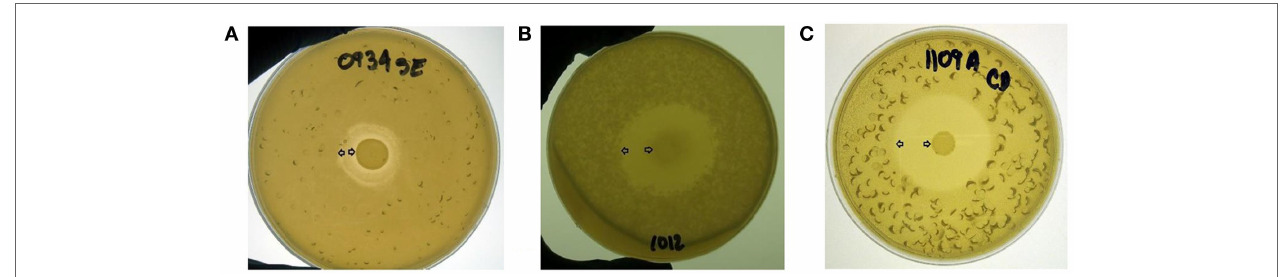
FigUre 2 | evaluation of antimicrobial activity from different Bacillus spp. isolates using an overlay method . A zone of inhibition is shown surrounding a tested bacterial colony located in the middle of the plate against (a) S. Enteritidis, (B) E. coli , and (c) C. difficile . All Bacillus spp. strains were screened by triplicate. Arrows indicate the bacterial colony and the outer limit of the zone of inhibition.